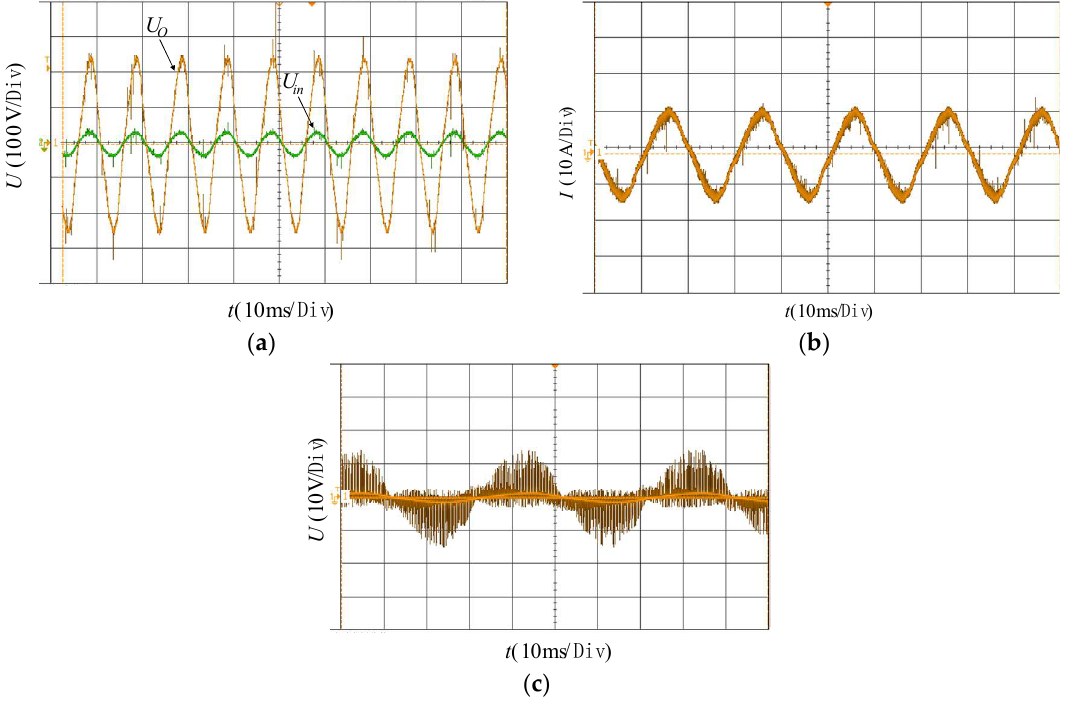
Figure 12. Experimental results based on an R load (D = 0.72, N = 1.5): ( a ) Input and output voltage; ( b ) Input current; ( c ) Voltage of the S 1 .